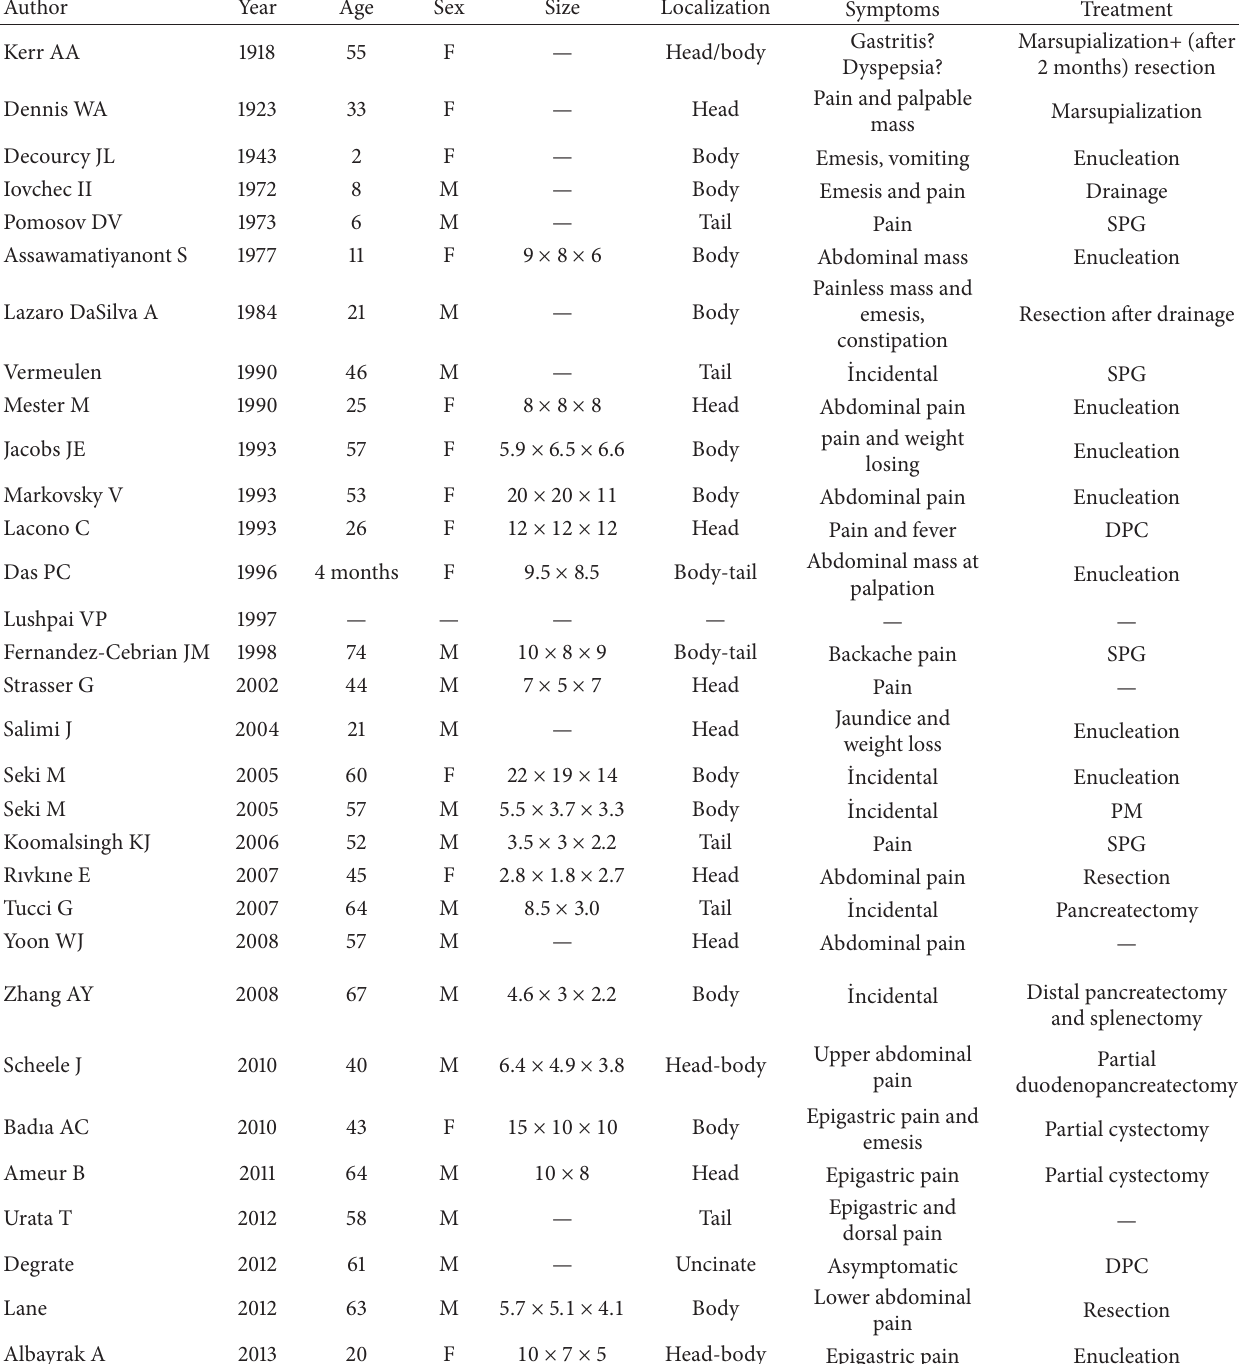
Table 1: A presentation of the cases of dermoid cyst of the pancreas found in the